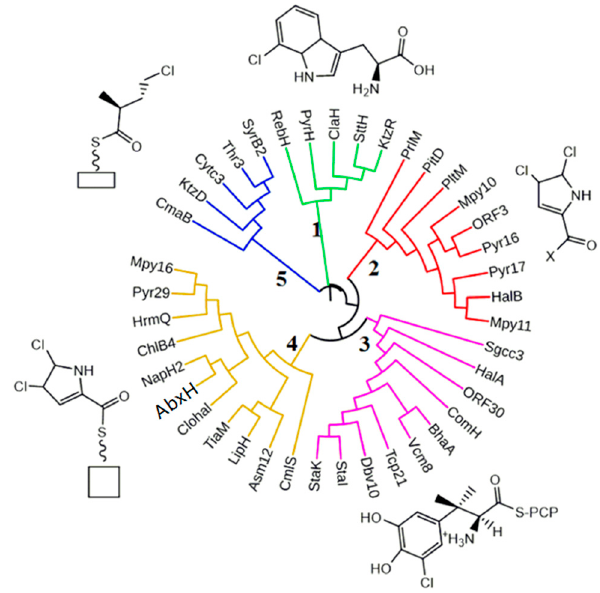
Figure 6. Phylogenetic analysis of identified halogenases from actinomycetes.